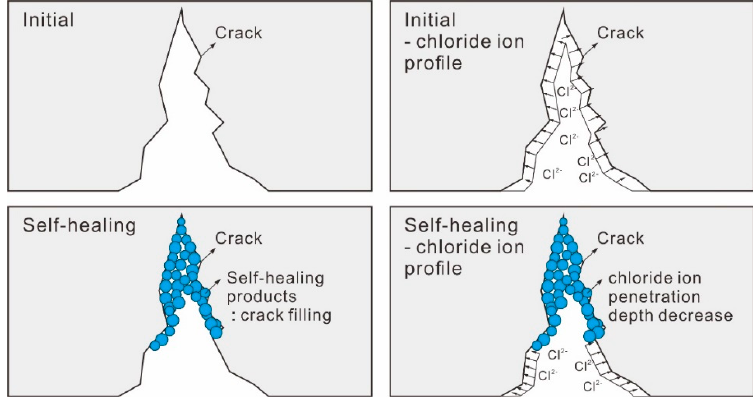
Figure 4. Cl penetration depth decreasing mechanism by crack self-healing.